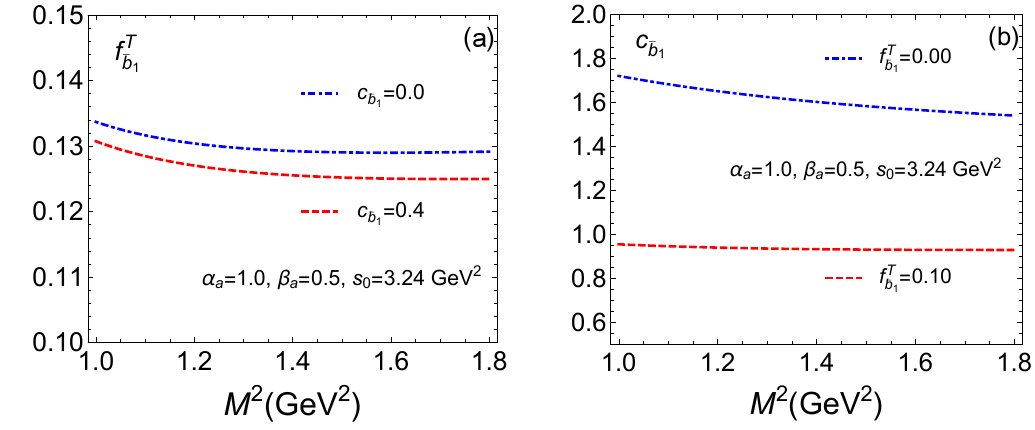
and (b) for the tensor current-hybrid b 1